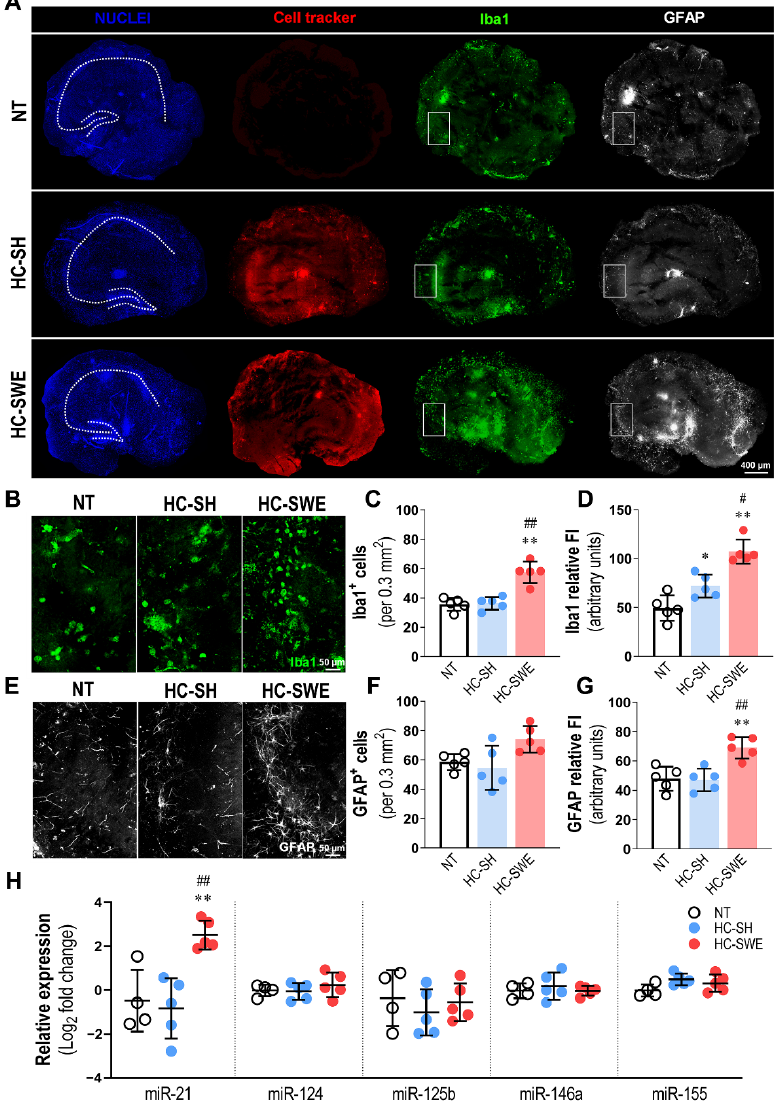
Figure 2. HC-SWE slices evidence an increased number of Iba1+ cells, enhanced Iba1/GFAP fluorescence intensities and upregulated miR-21 expression as compared with NT and HC-SH slices. ( A ) Representative fluorescence images of non-transplanted (NT) and hippocampal cultures with engrafted cells (HC-SH and HC-SWE). Nuclei (in blue), cell tracker+ (in red), Iba1+ (in green) and GFAP+ (in white), all shown separately. Dotted lines represent a schematic outline of the hippocampal structure. White rectangles are sections from similar hippocampal regions used for the close-up visualization. ( B ) Close-up images of Iba1+ cells. ( C ) Total quantification of the number of Iba1+ cells and ( D ) total Iba1 fluorescence intensity. ( E ) Close-up images of GFAP+ cells, ( F ) total quantification of the number of GFAP+ cells and ( G ) total GFAP fluorescence intensity. ( H ) miRNA quantification in HC-SWE vs. NT hippocampi, presented as the binary logarithm of fold change. Scale bars corre- spond to 400 µ m ( A ) and 50 µ m ( B , E ). Results are mean ± SEM from five independent experiments. Two-tailed Student’s t -test: * p < 0.05 and ** p < 0.01 vs. NT; # p < 0.05 and ## p < 0.01 vs. HC-SH. SH, SH-SY5Y neuroblastoma cells; SWE, SH-SY5Y cells expressing human APP695 Swedish mutation; NT, non-transplanted hippocampal slices; HC-SH, hippocampal slices transplanted with SH cells; HC-SWE, hippocampal slices transplanted with SWE cells; FI, fluorescence intensity; GFAP, Glial fibrillary acidic protein; Iba1, ionized calcium binding adaptor molecule